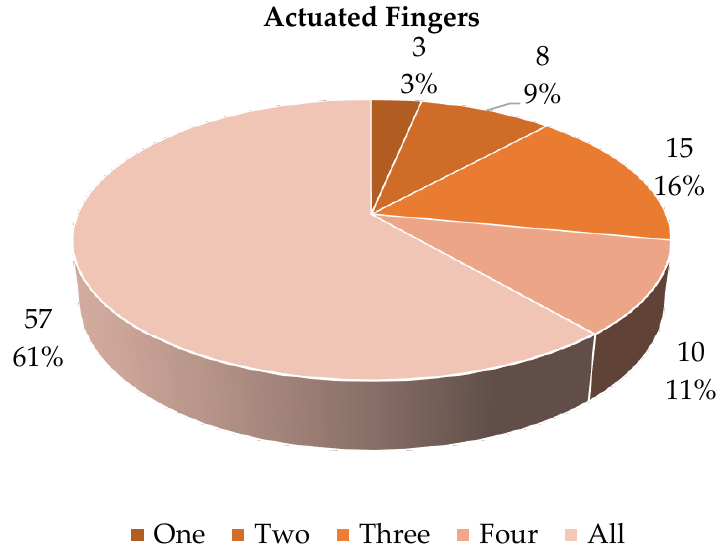
Figure 19. Actuated